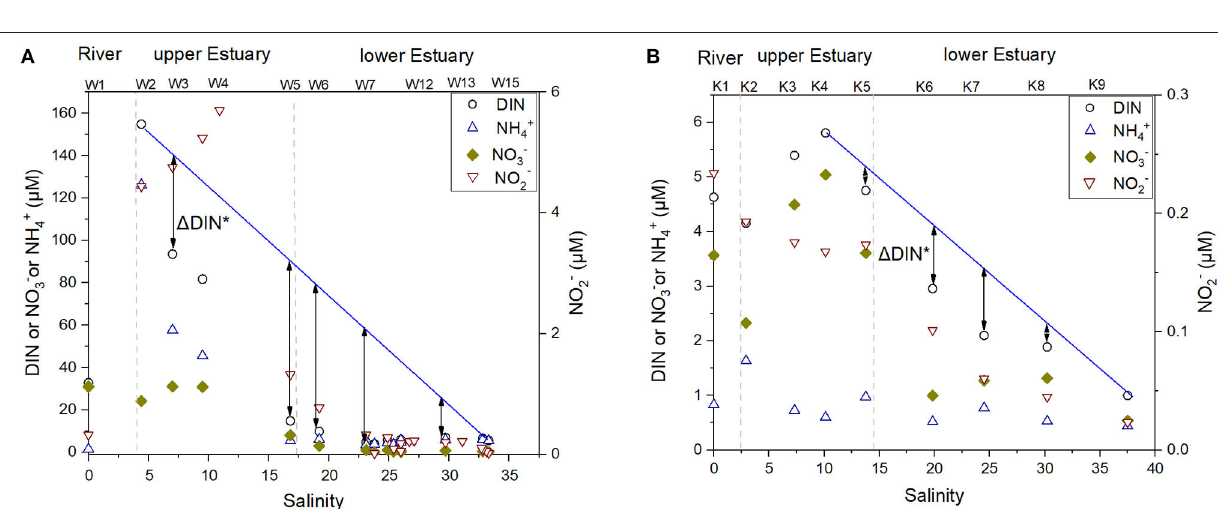
234% in the upper estuary section and dropped to 39 and 119% in the lower estuary section (mean 91%) ( Figure 2 ). ( Table 1 ). The DIN/DIP ratio was extremely high (425) in the river, while a sharp decrease occurred in the estuary with an average DIN/DIP ratio of 7 in the lower estuary ( Table 1 ), and the minimum DIN/DIP ratio was as low as 2 (W8). DOC in the whole WRE was 239 ± 62 µ M. An inverted-U shaped pattern was found for the DOC distribution from the river to the estuary ( Figure 4 ). The increase of DOC from the river to the upper estuary occurred in the salinity range from 0 to 16.8 (W1– W5), where the mangrove exists ( Figure 1A ). In the middle and the bottom water layers, DOC concentrations were lower (102– 220 µ M) compared to the corresponding surface DOC values (surface mean DOC concentration was 239 µ